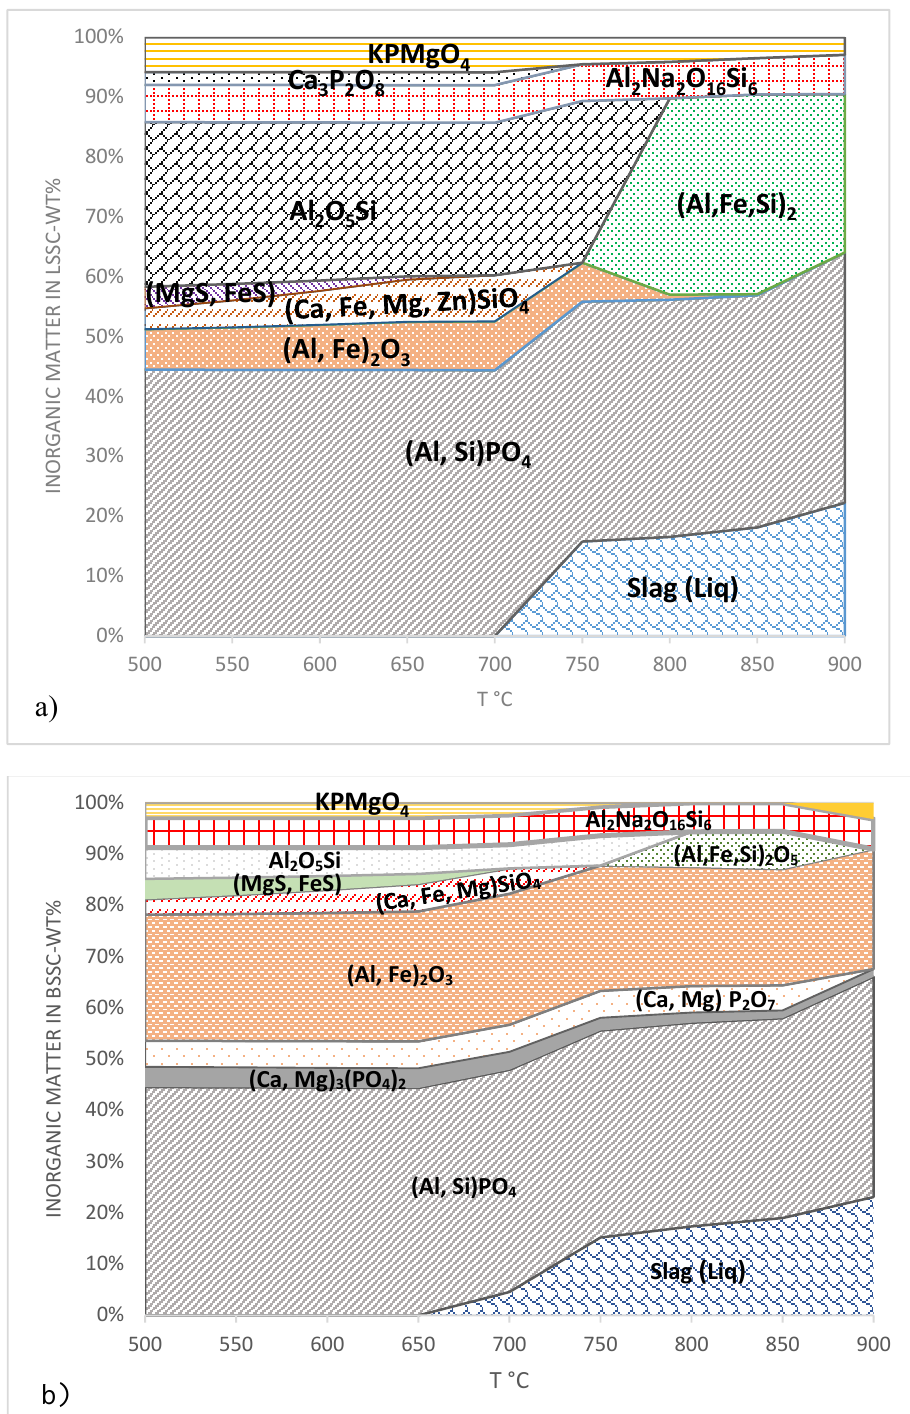
Figure 12. The calculated equilibrium composition of char after pyrolysis at different temperatures: ( a ) LSSC and ( b ) BSSC.